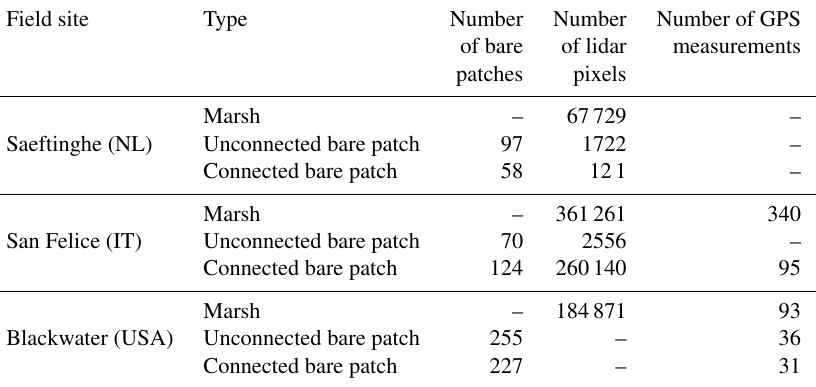
Table 1. Overview of bare patch number (bare patches smaller than 1m 2 were excluded from the analysis), lidar pixels, and GPS measure- ments of the three field